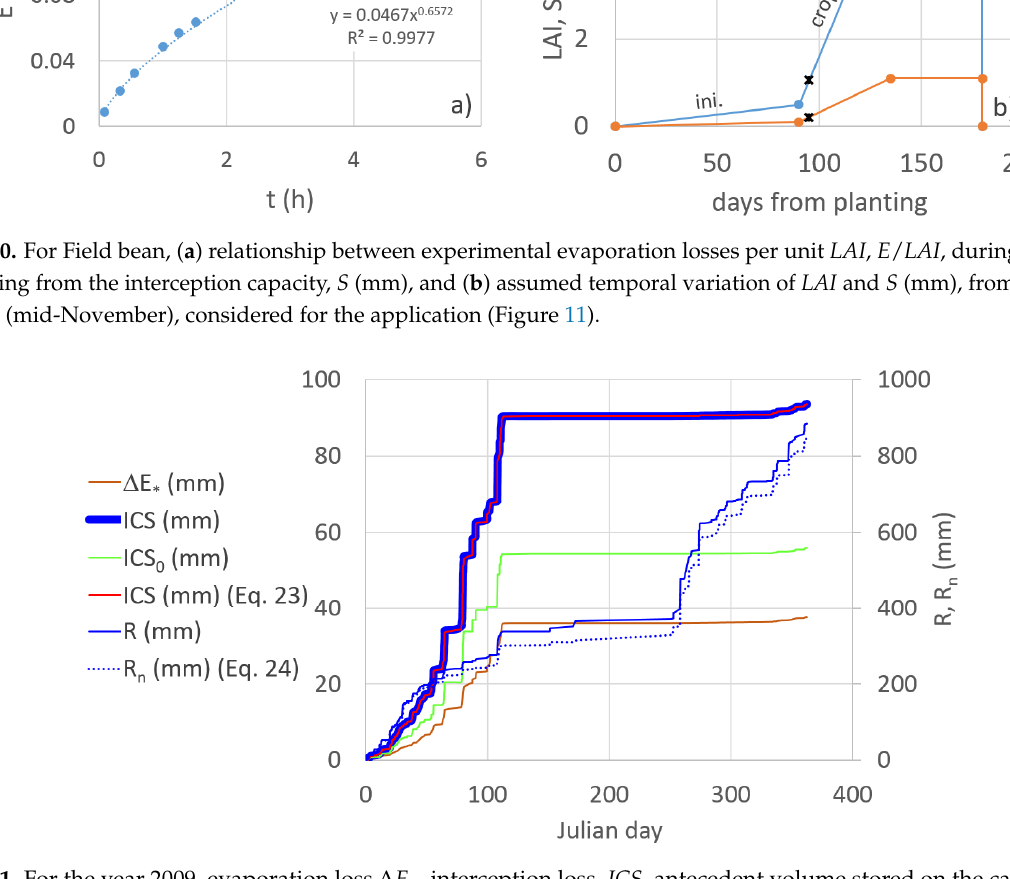
Figure 11. For the year 2009, evaporation loss ∆ E ∗ , interception loss, ICS , antecedent volume stored on the canopy, ICS 0 . The figure also illustrate the water mass balance (red line) that was checked by using Equation (23), and the gross and net rainfall depth, R and R n (Equation (24)), respectively (secondary axis).